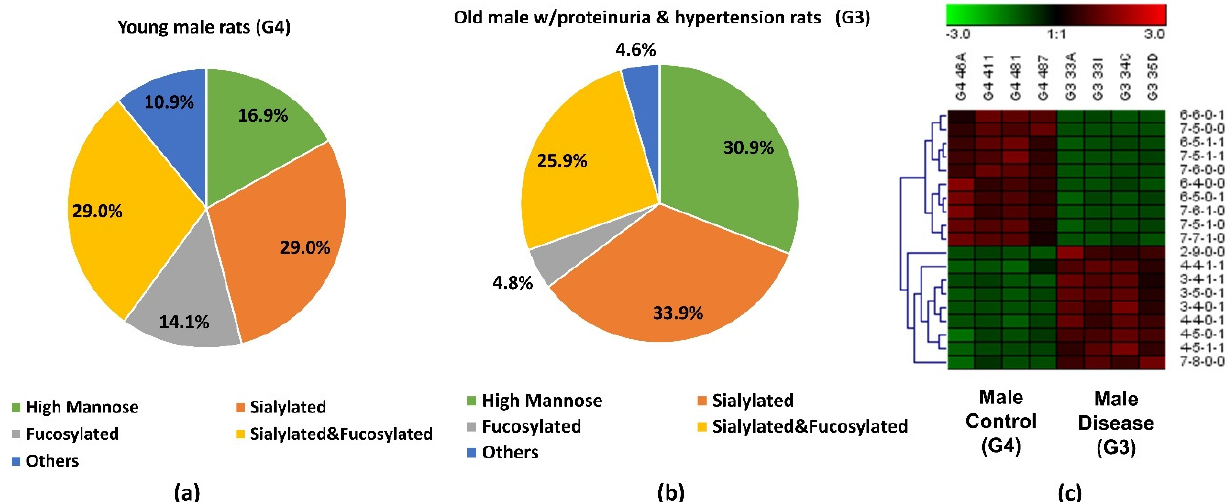
Figure 3. Distribution changes of different N -glycan types from ( a ) young male control (G4) and ( b ) old male with proteinuria and hypertension (G3); ( c ) Heatmap of 19 N -glycans that exhibited significant expression changes between G3 and G4. In the heatmap, each row represents an individual significant N -glycan. The red color of the cell denotes a high relative abundance, while the green color represents a low relative abundance of the N -glycan.